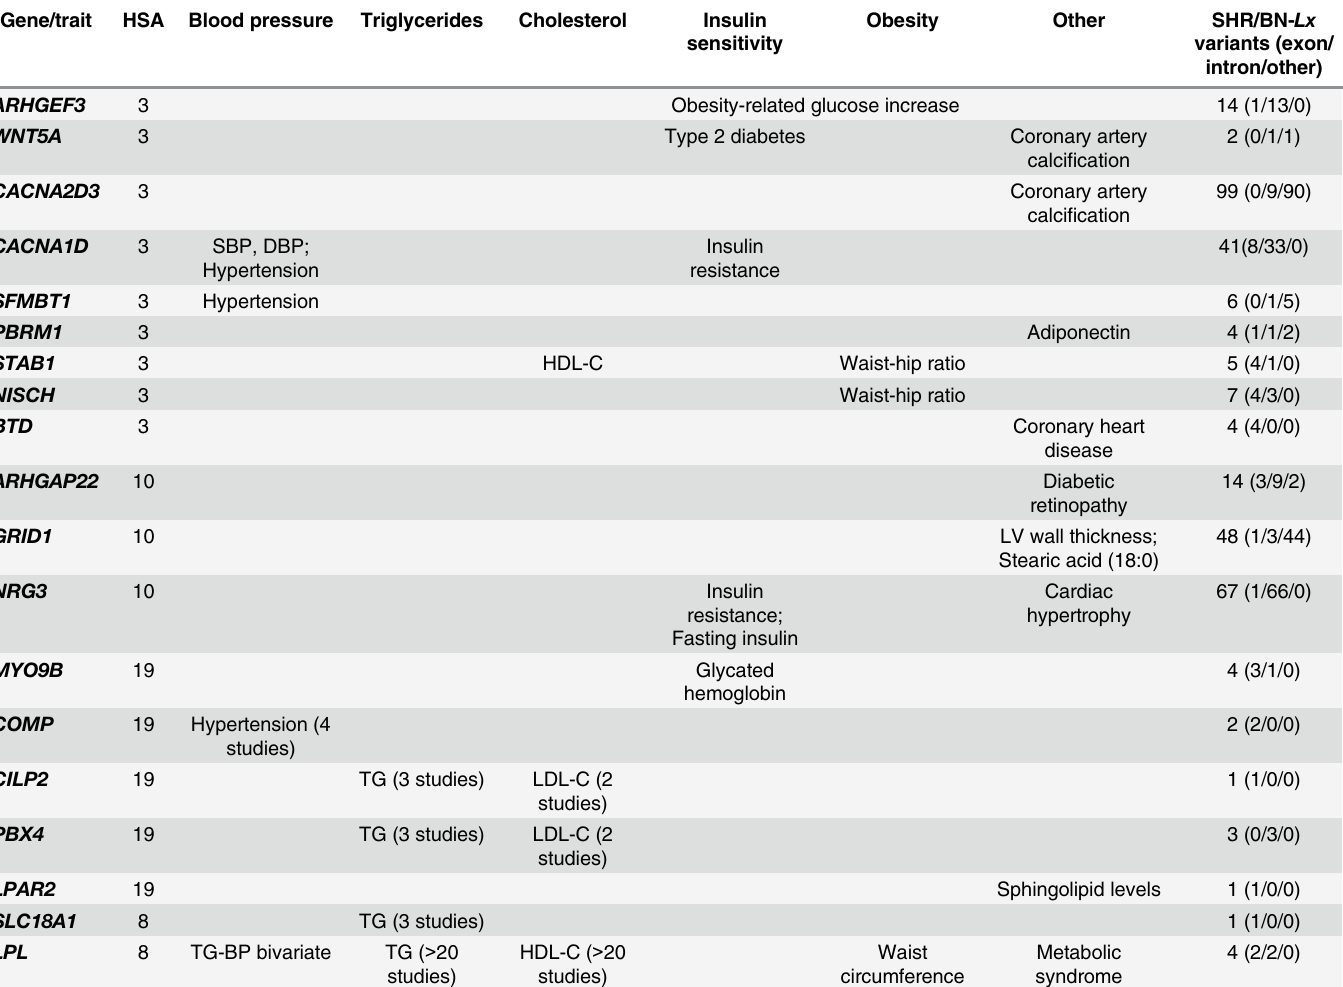
Table 3. Genome-wide association studies in human subjects: reported significant